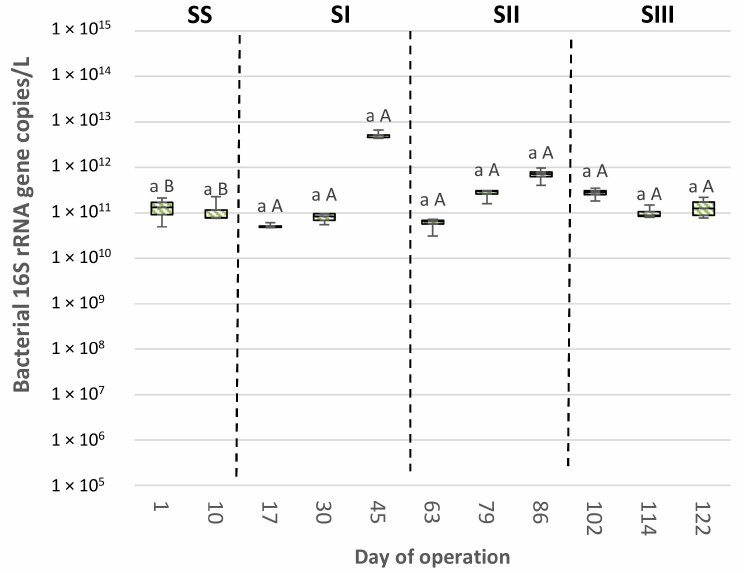
Figure 2. Bacterial 16S rRNA genes copies per liter of enriched activated sludge determined by quantitative PCR in sludge samples ( n = 2) retrieved from an enrichment SBR operated under saline conditions (SBR-S, 10 g NaCl/L). Different lowercase letters indicate significant differences among periods for a given bioreactor (NS, NI, NII, or NIII; SS, SI, SII, or SIII) according to the Kruskal–Wallis and Conover–Iman tests ( p < 0.05). Different capital letters indicate significant pairwise differences between bioreactors for a given period (NS vs. SS; NI vs. SI; NII vs. SII; or NIII vs. SIII) according to the Mann–Whitney test ( p <